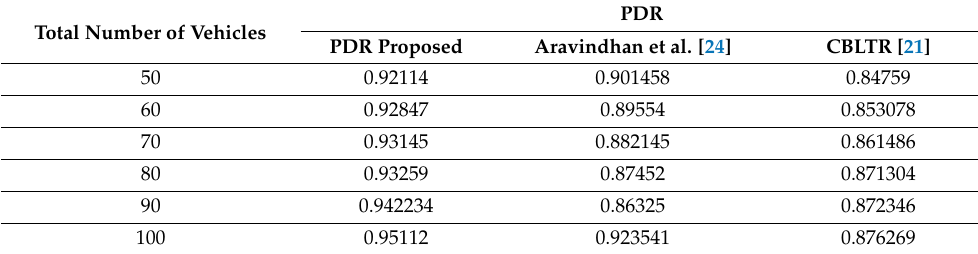
Table 4. PDR versus vehicular nodes in Area (1000 × 1000).